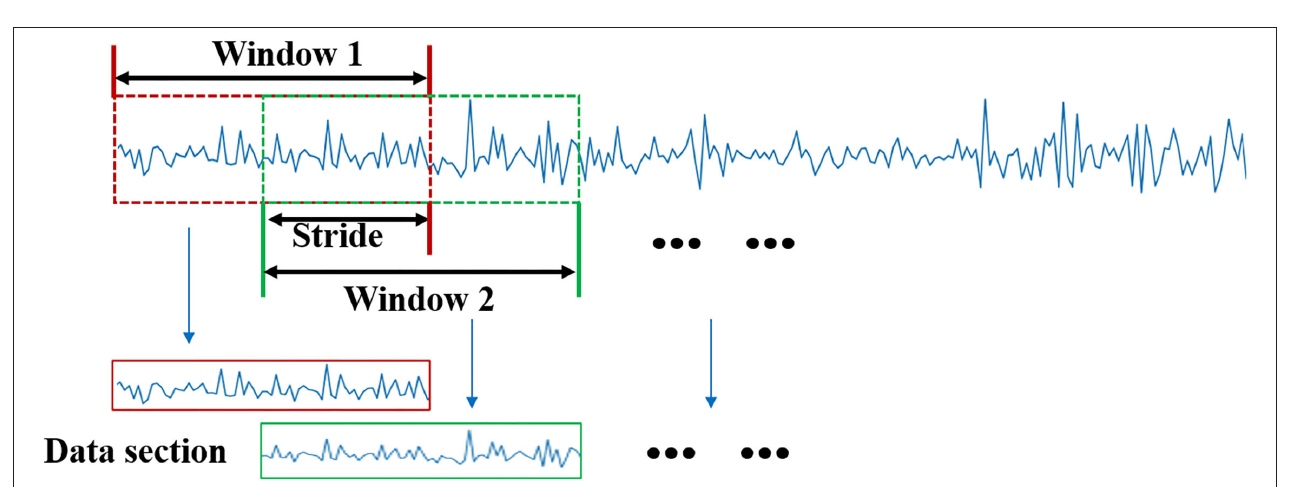
FIGURE 1 | Flowchart of the proposed gesture recognition method.